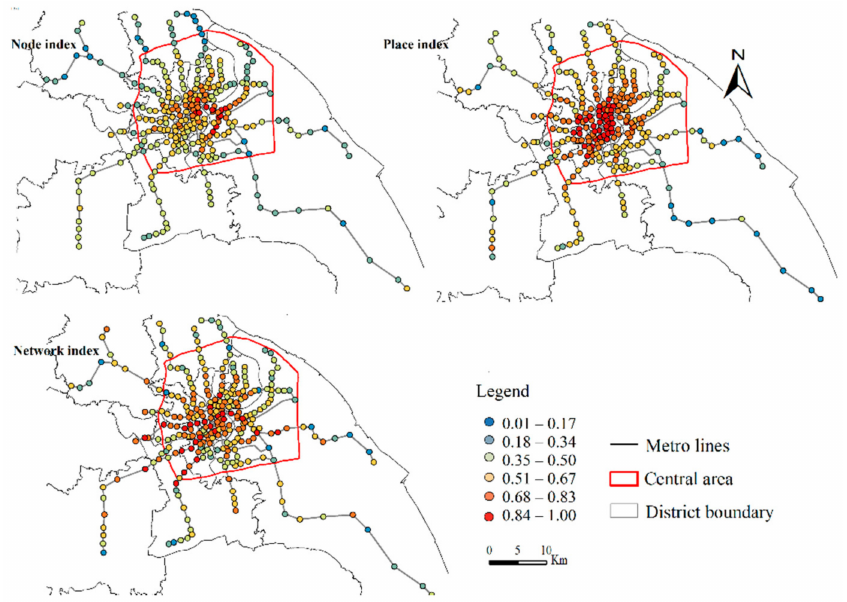
Figure 5. Node, place, and network indexes of the metro stations.